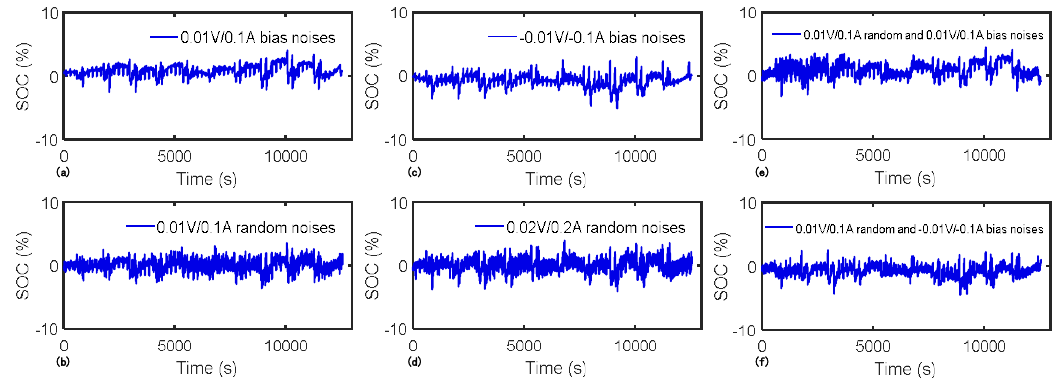
Figure 7. SOC estimation with measurement noises under the NEDC. Table 3. Mean and maximum SOC error with measurement noise under the